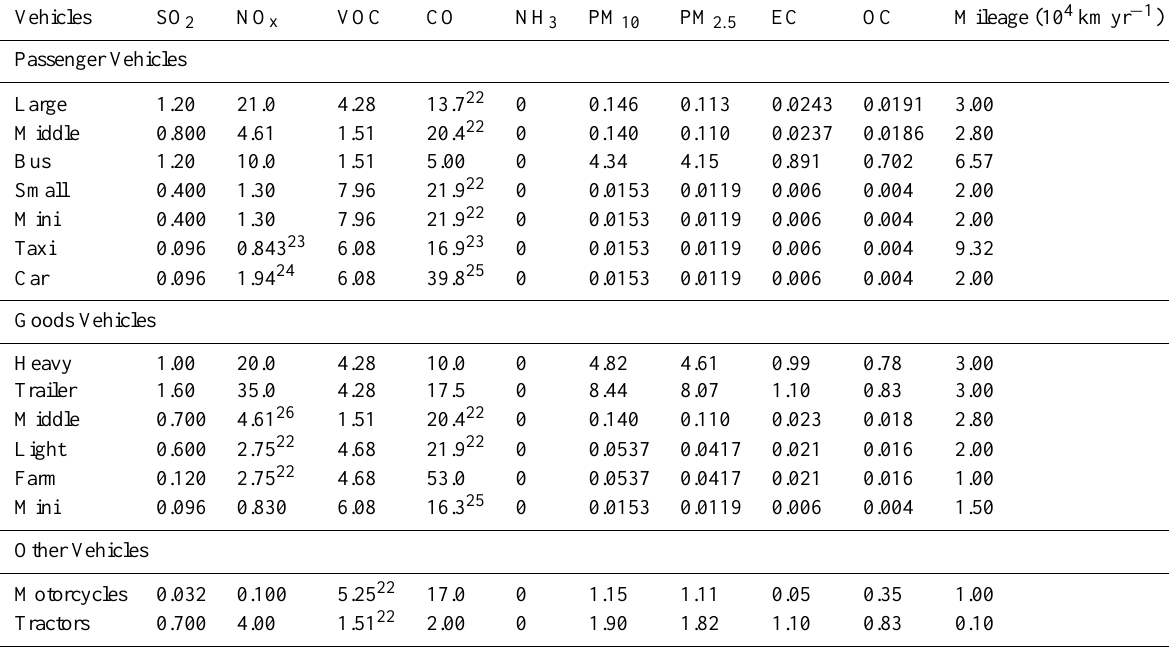
Table 11. Emission factors for motor vehicles (units: gkm − 1 ).